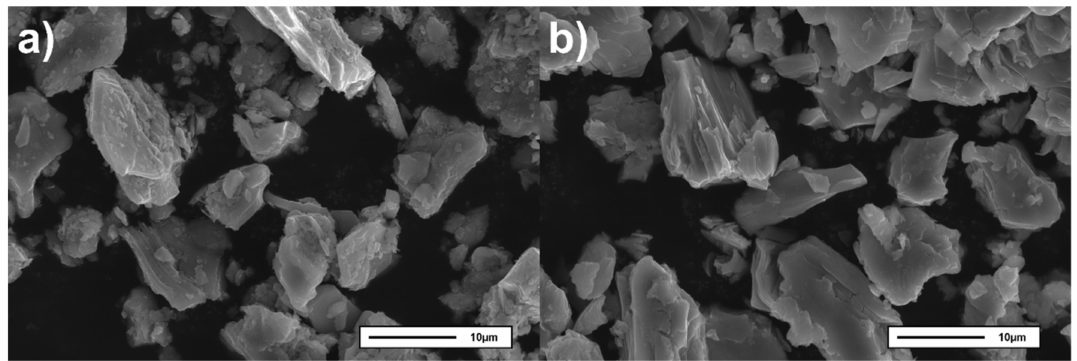
Figure 1. SEM micrographs of self-synthesized powders of ( a ) Ti3SiC2 and ( b ) Cr2AlC MAX phases.